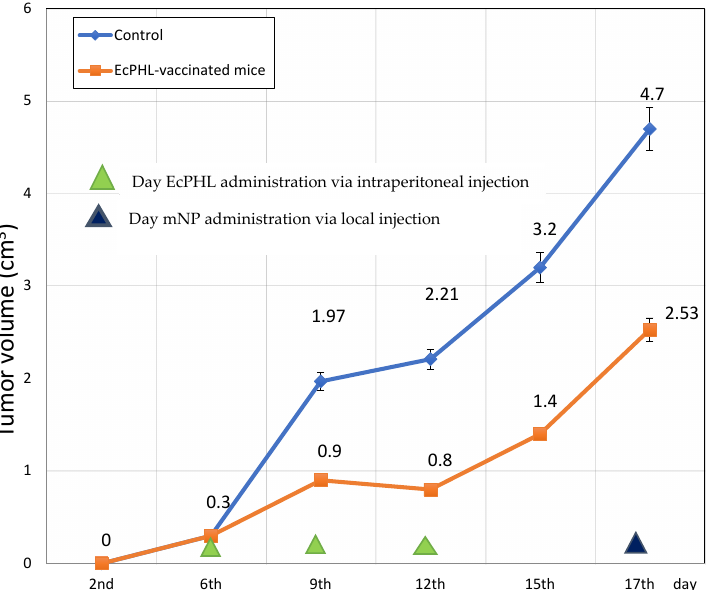
Figure 1. Tumor volume (cm 3 ) in the Group I mice (control, untreated) and the Group II EcPHL- vaccinated mice. To further demonstrate the efficacy of the EcPHL immune modulator, Figure 2 shows comparisons between the tumor tissue samples for the EcPHL-treated and control (un- treated) mice. The visual comparisons clearly show the difference in tumor tissue size be- tween treated and untreated Ehrlich-carcinoma-bearing mice.